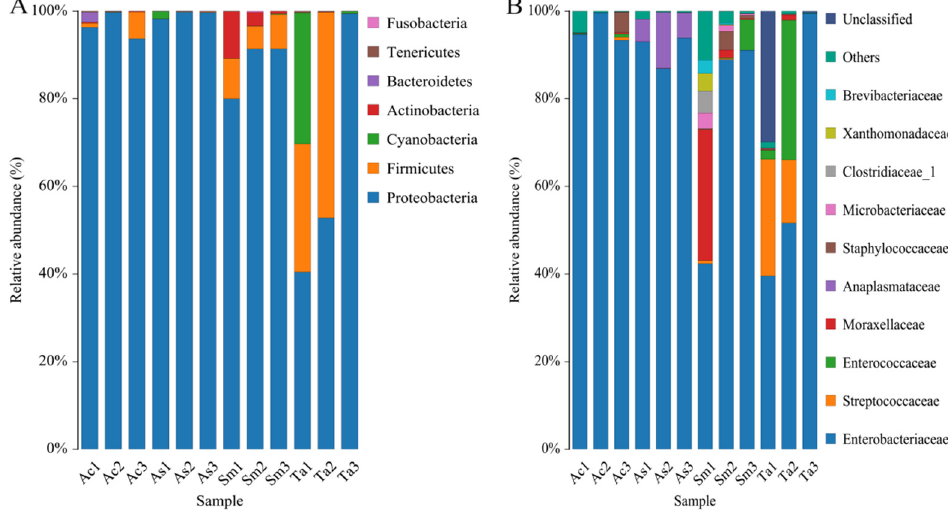
Figure 3. Bacterial abundance histogram at ( A ) the phylum level and ( B ) the family level. Each color represents a species, and the height of the color block indicates the proportion of the species in relative abundance. The top 10 genera in relative abundance were shown in Figure 3B. “Others” represented the remaining. “Unclassified” represented OTUs that were not commented. Ac, Acridia chinensis ; As, Atractomorpha sinensis ; Sm, Sphingonotus mongolicus ; Ta, Trilophidia annulate .